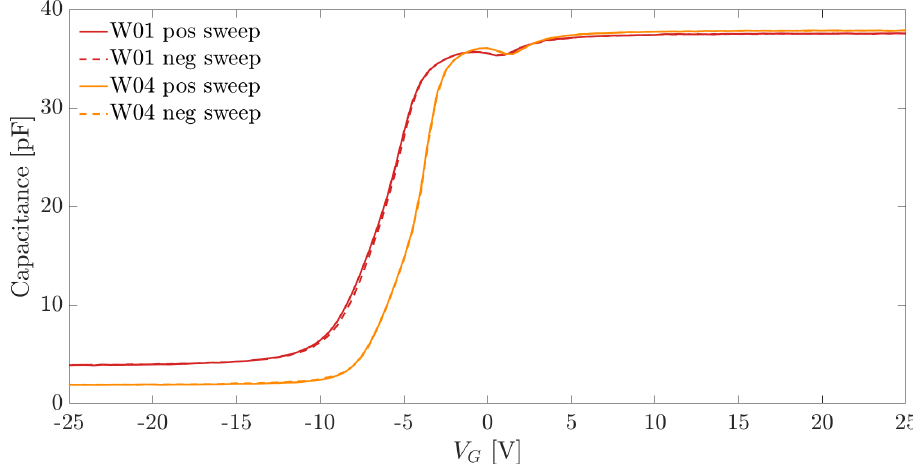
Figure 9. C–V curves of MOS capacitors from two different